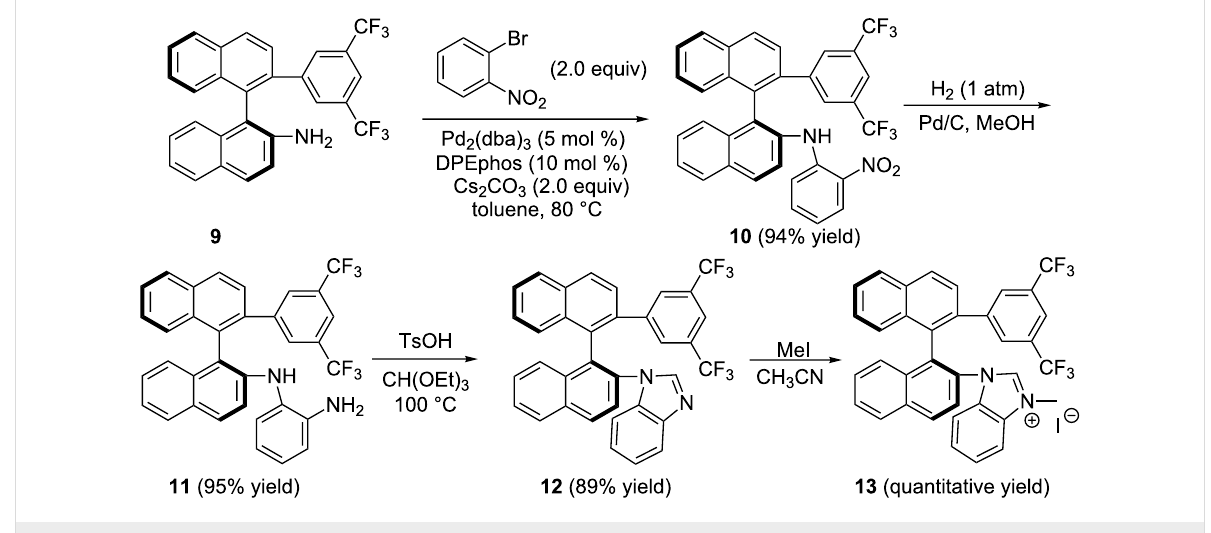
Scheme 2: Synthesis of N -heterocyclic carbene precursor.